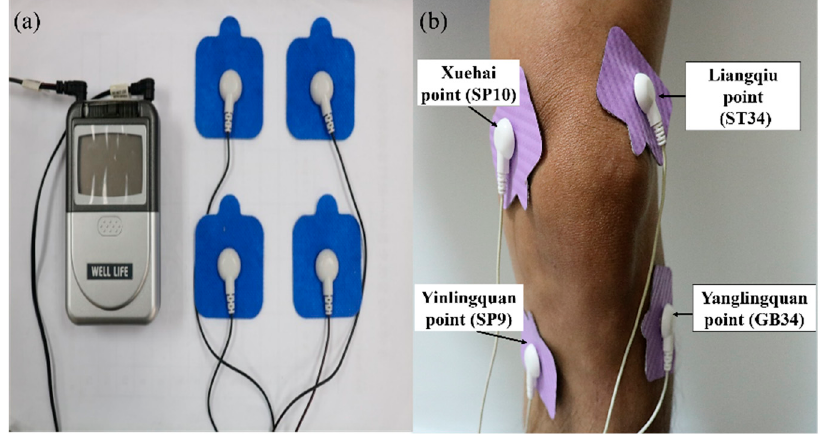
Figure 2. Illustration of the transcutaneous electrical nerve stimulation (TENS). ( a ) TENS. ( b ) TENS pads were attached at ST34, GB34, SP10, and SP9.